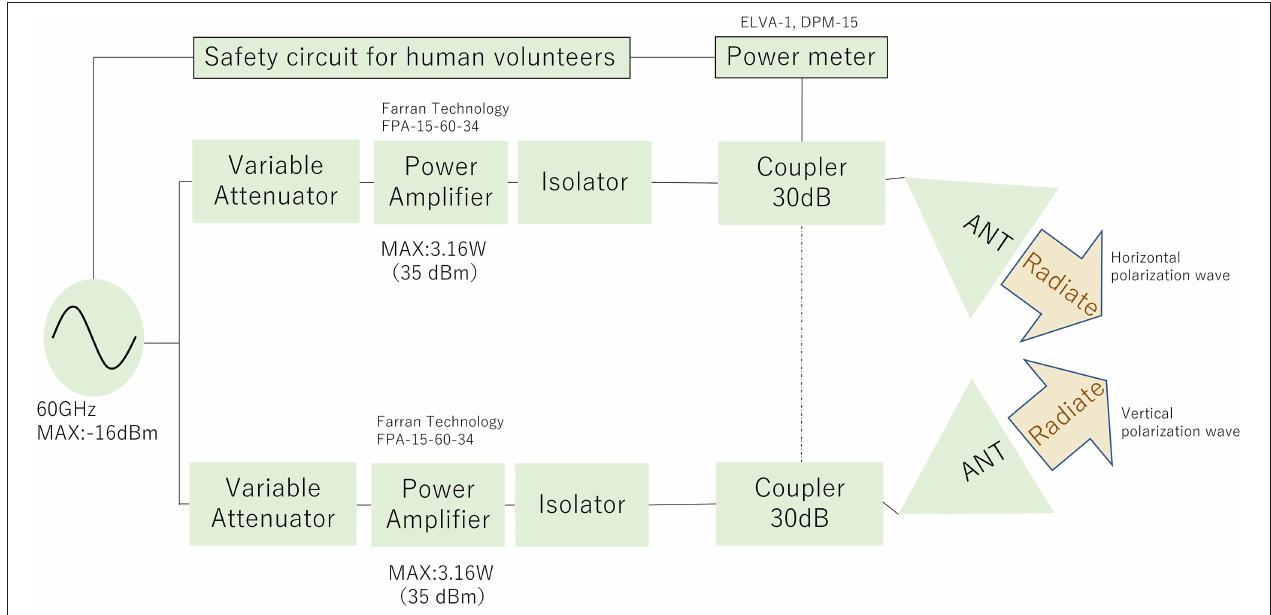
FIGURE 2 | Designed block diagram of the proposed exposure setup using spatial synthetic